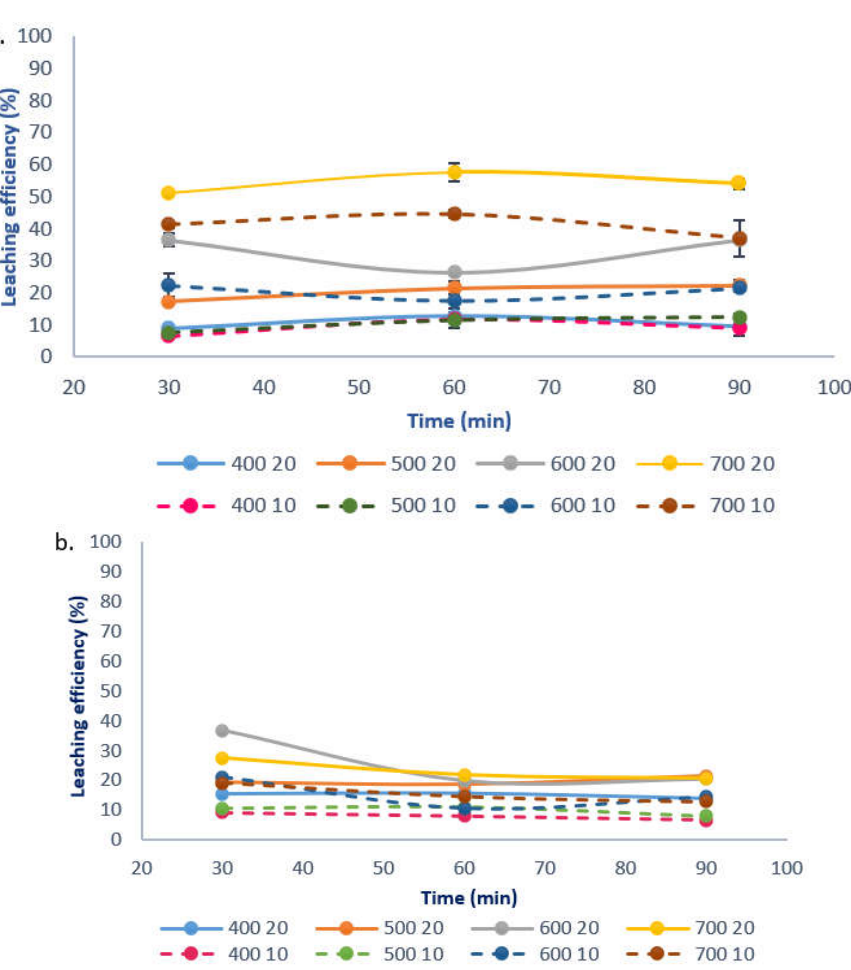
Figure 3. The effect of L/S ratio on Li leaching efficiency: ( a ) pyrolysis and ( b ) incineration (Leaching condition: L/S ratio = 20:1 and 10:1 mL g −1 , 80 °C, 300 rpm, and 3 h).